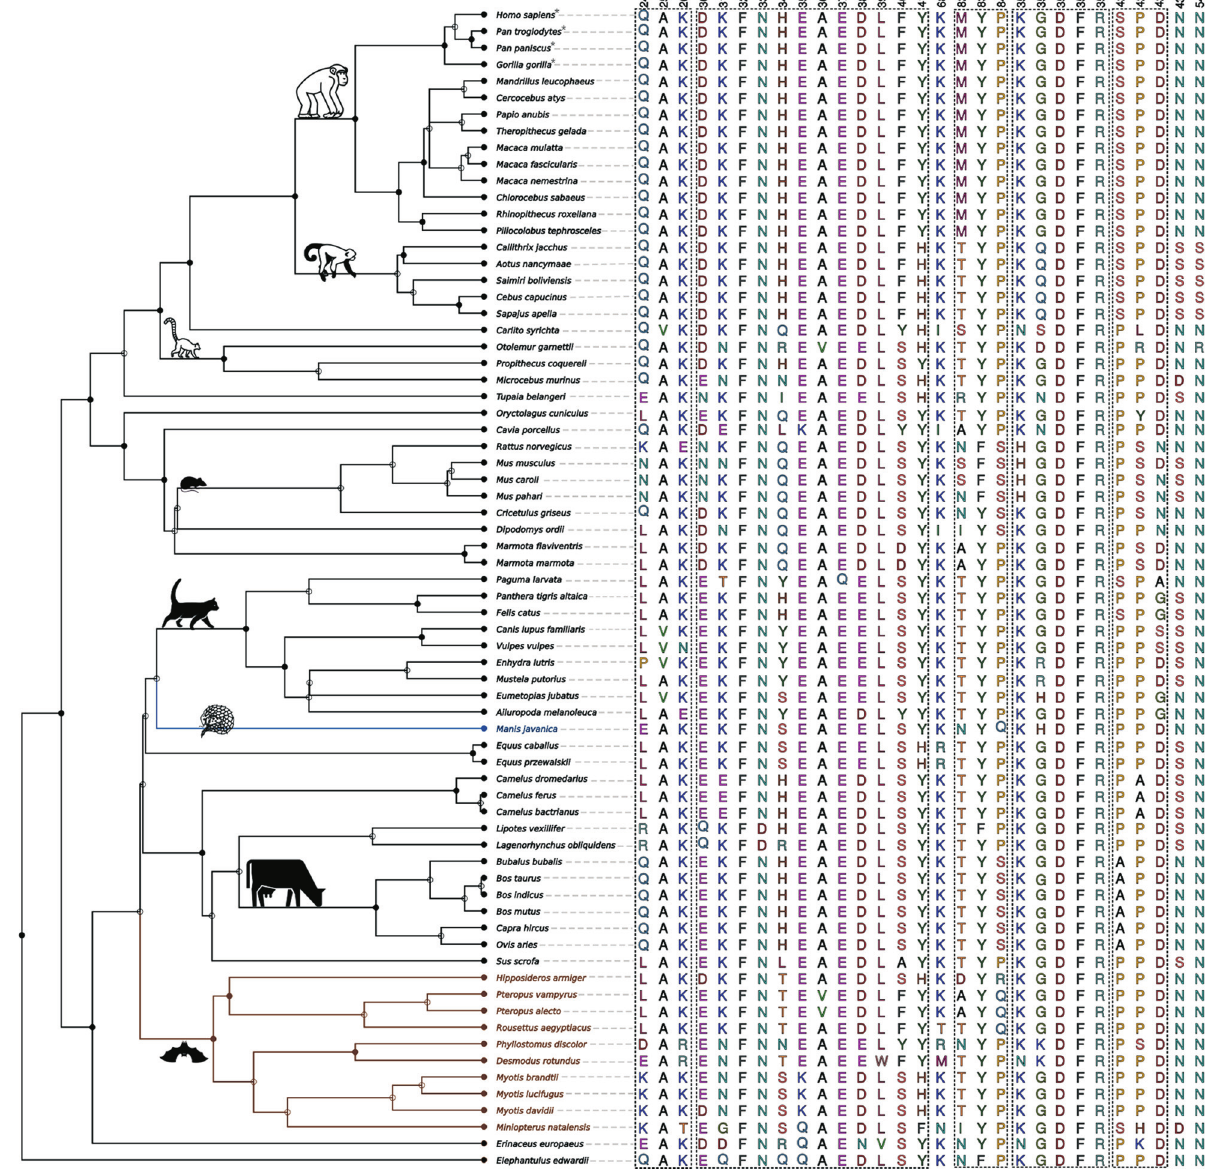
Figure 2 - Crucial variable sites in placental mammalian ACE2 protein in the interaction with SARS-CoV-2. In color branches potential sources of SARS-CoV-2; in blue, Pangolin ( Manis javanica ) branch, and in brown bat (Chiroptera) branches.* Species whose susceptibility to infection by SARS-CoV-2 may be similar to human. The full nodes in the tree are those in which we have a taxonomic classification defined as order, family, gender, etc., while those with an empty node, this information is not well supported. Animal icons available in Noun project